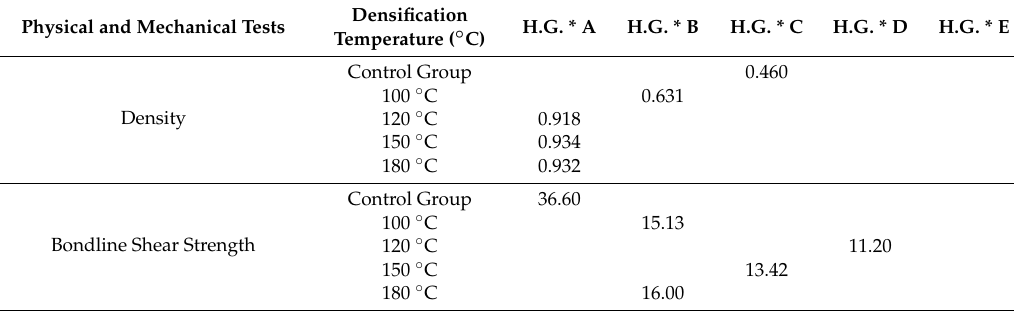
Table 4. Comparative test results for the effect of densification on various properties of the samples at different temperatures for homogeneity